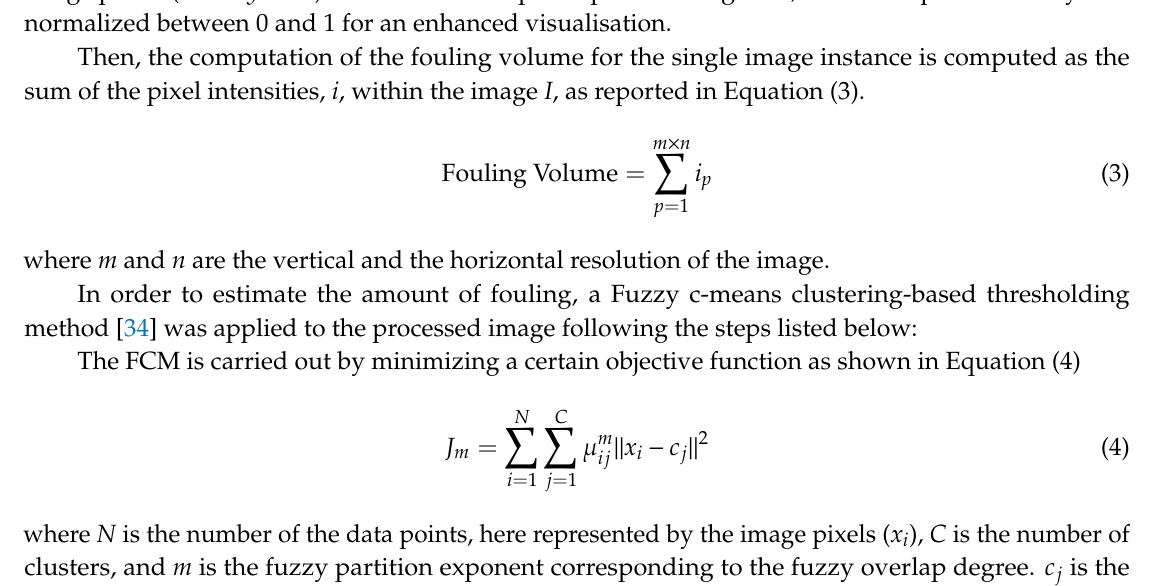
Figure 8. Processed image for fouling estimation.